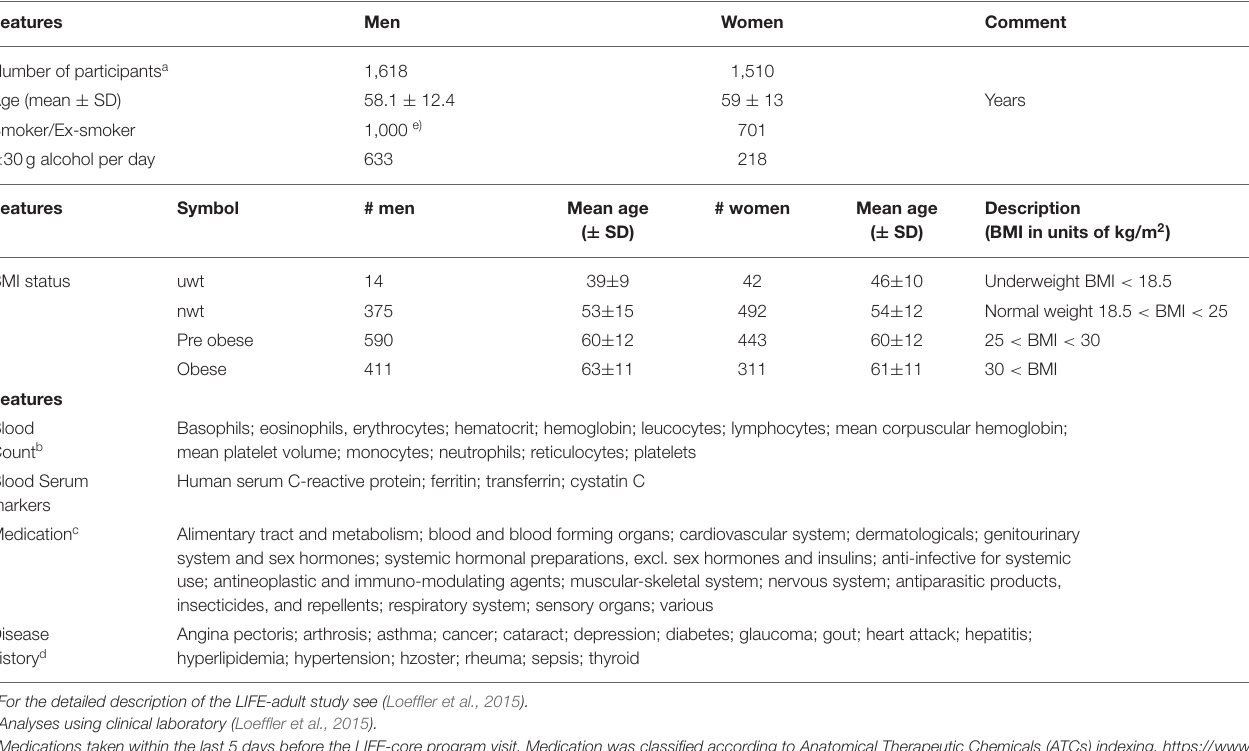
TABLE 1 | Participant’s characteristics of the LIFE-adult study used in this publication for association with the blood transcriptome (see also Supplementary Table 1 in Supplementary File 1 for further details).